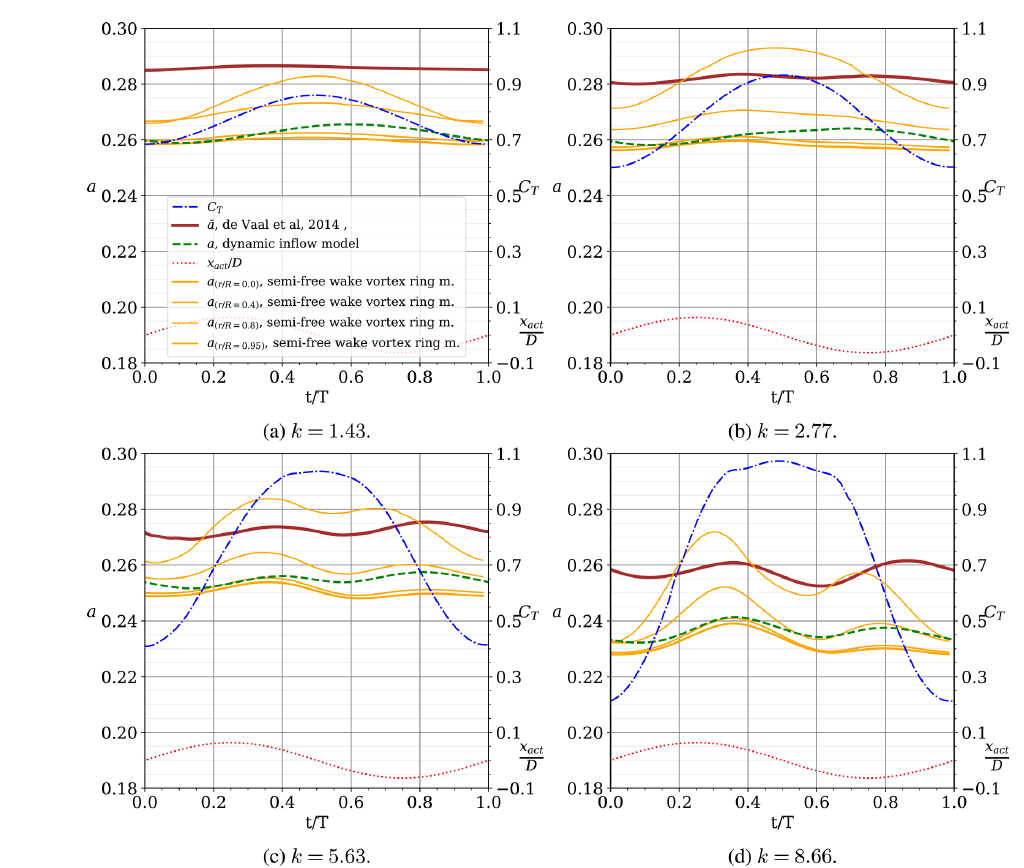
Figure 3. Comparison of the results of induction by de Vaal et al. (2014) ( a average induction factor over the actuator), the semi-free-wake vortex ring model ( a at different radial positions r/R ) and the new proposed dynamic inflow model. The four case studies are defined by a = 0 . 063D and k = 1 . 43, 2 . 77, 5 . 63 and 8 . 66. The sin( kU ∞ /Dt ) with A x surge motion of the actuator sinusoidal motion with x act = A x act act resulting thrust coefficient C T is also plotted. The results are plotted over one period, along the non-dimensional time t/T . All values are non-dimensional with relation to U ∞